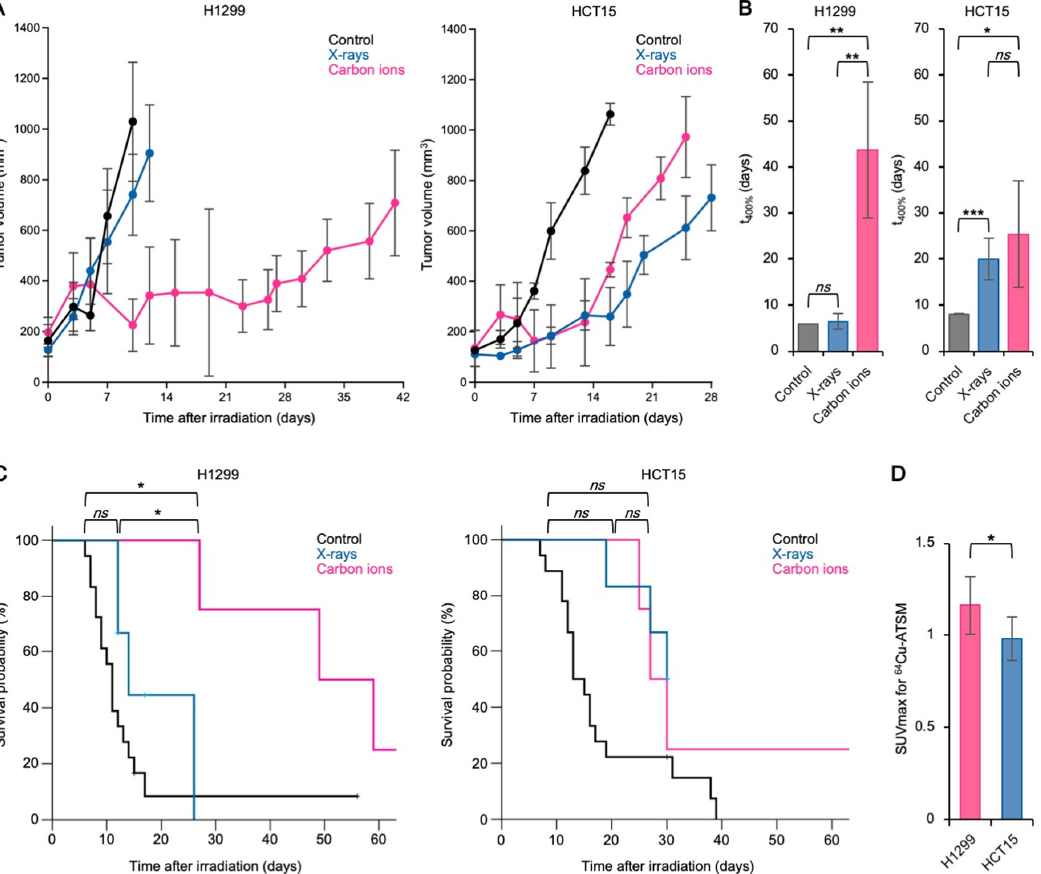
Figure 2. The carbon ion RBE correlates with 64 Cu-ATSM uptake in vivo. ( A ) Growth of tumor xenografts treated with carbon ions (10 Gy) or X-rays (10 Gy) (mean ± SD; n = 4). ( B ) t 400% (i.e., the time required for the tumor volume to reach 400% of that measured on Day 0) for the data presented in A. ( C ) Kaplan-Meier survival estimates of mice bearing HCT15 or H1299 xenografts ( n = 20, four, and four mice in the control, X-ray, and carbon ion groups, respectively). ( D ) 64 Cu-ATSM uptake by tumor xenografts, as assessed by PET imaging (mean ± SD; n = 9). * p < 0.05; ** p < 0.01; *** p < 0.001. ns , not statistically significant.